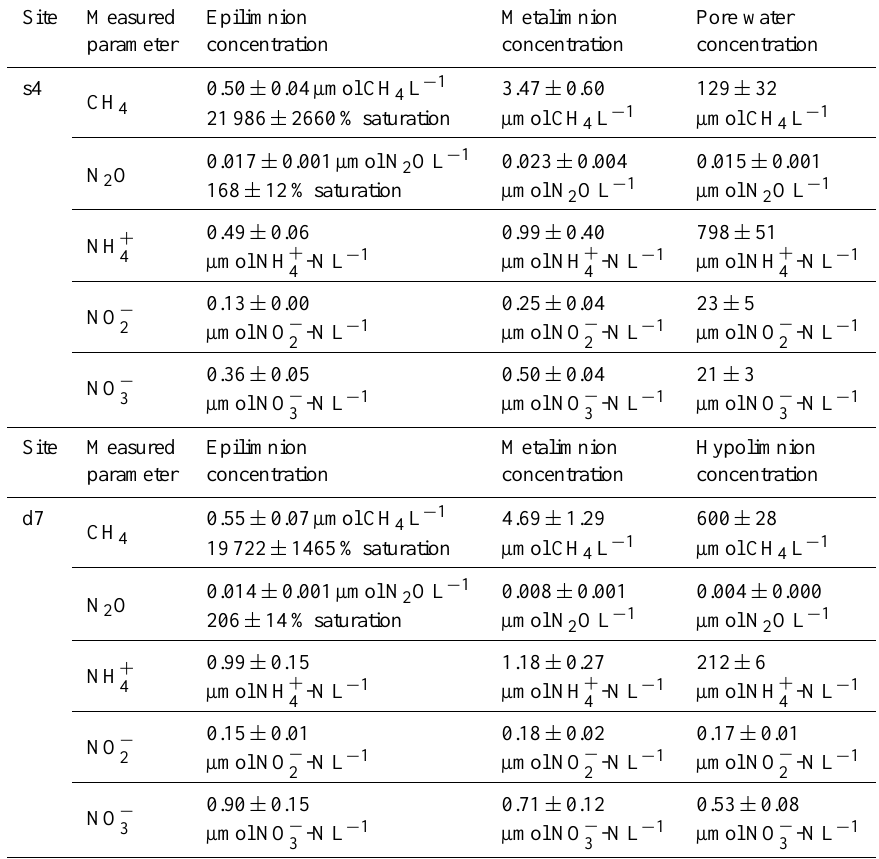
Table 3. Measured methane, nitrous oxide and nutrient concentrations of the detailed study at the shallow site s4 in the epilimnion, metal- imnion and pore water and at the deep site d7 in the epilimnion, metalimnion and hypolimnion. Values represent the average ± SE: n = 12 for water column methane and nitrous oxide; n = 15 for water column nutrients; n = 4 for pore water methane and nitrous oxide and n = 8 for pore water nutrients.